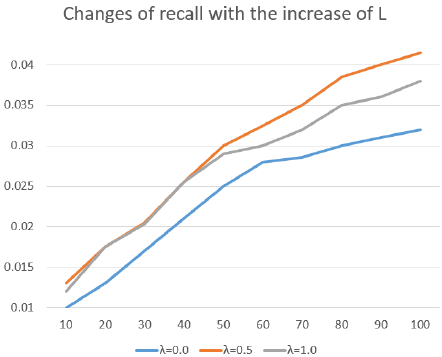
Fig. 7. The changes of recall with the increase of L, Y axis represents recall and X axis represents L (L is the length of recommendation list).